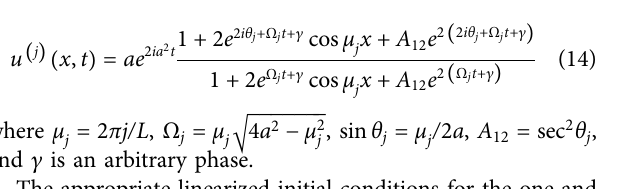
FIGURE 10 | Three UM regime: (A) δ (cid:1) 10 − 5 , ... , 10 − 4 and c (cid:1) 0 .